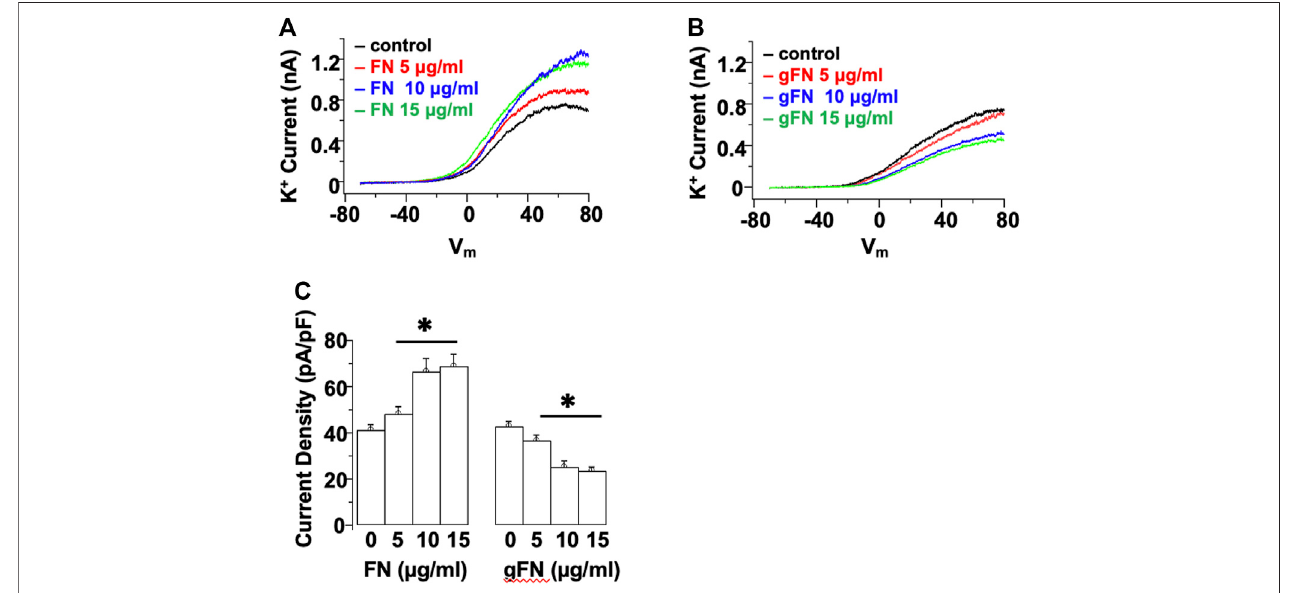
FIGURE 1 | Acute application of native FN evokes a concentration — dependent increase in whole cell K + current, whereas gFN causes a concentration — dependent inhibition of K + currents. Panels (A,B) show representative I – V responses in single cerebral VSMCs in the presence of increasing concentrations of native and modi fi ed FN. Whole cell currents were evoked by a voltage ramp from − 70 to +80 mV and are displayed as the averages of three consecutive ramps under each condition. (C) shows group data at +70 mV ( n = 12; mean ± SEM). * p < 0.05 compared to control response in the absence of FN or gFN.